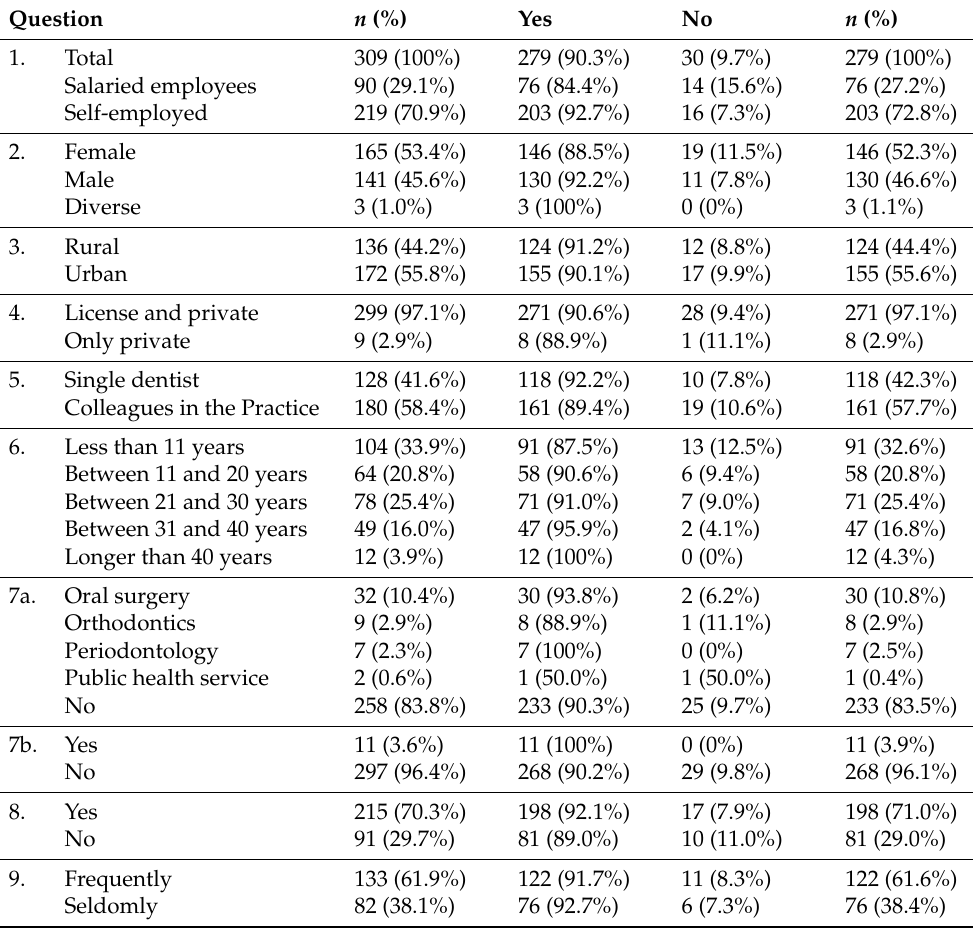
Table 1. Questions on the person, work environment and qualification (Section